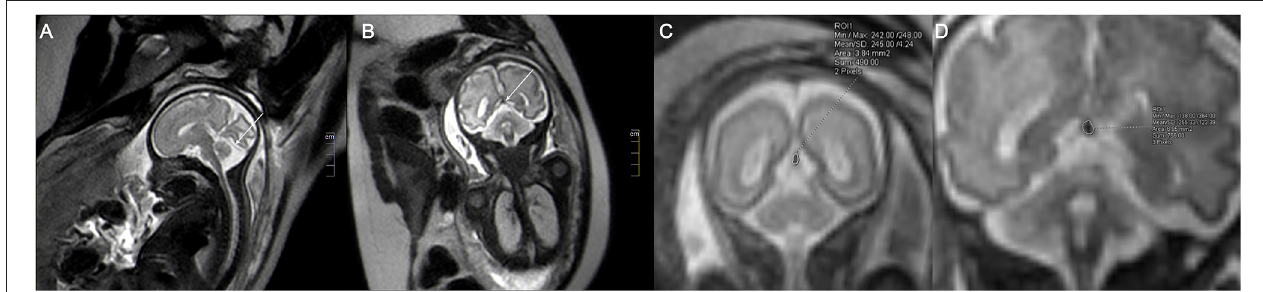
FIGURE 1 | The single shot-fast spin-echo sequence of a normal fetus at a gestational age of 32 weeks. The sagittal plane (A) shows the intact straight sinus (arrow), and the coronal plane (B) shows the cross-section of the fetal straight sinus (arrow) with measurement of the cross-sectional area. (C) (image magnification, × 8) and (D) (image magnification, × 10) show 23 and 31-week fetuses, respectively. The measurement method of straight sinus and the measured sectional area are shown in the figure.